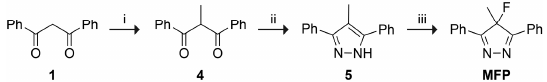
Figure 2. Reaction of endo -bicyclo[6.1.0]non-4-yn-9-ylmethanol (BCN) (1, 5, or 10 mM) with 4-fluoro- 4-methyl-3,5-diphenyl-4 H -pyrazole (MFP) (0.1 mM) in 9:1 methanol/water. Values of k obs are the mean